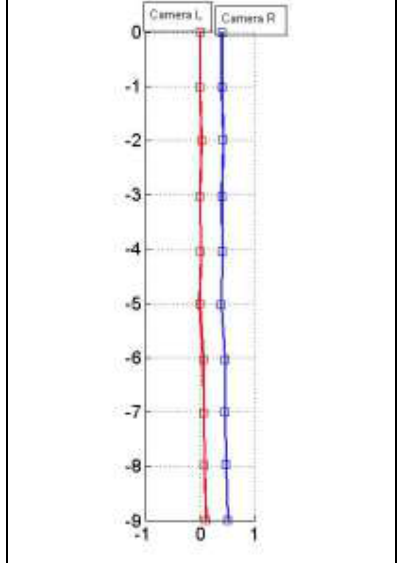
Figure 7 – Orthogonal plot of all PC estimated positions in the LACRF (Exp